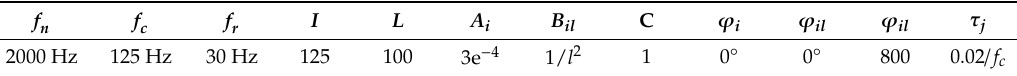
Table 1. Parameters in the simulated bearing inner race fault